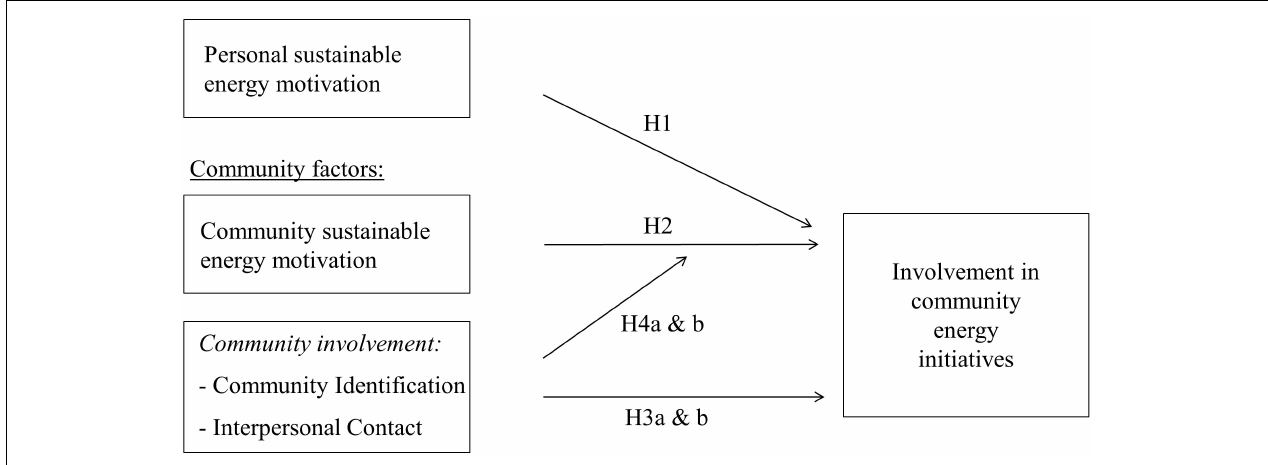
FIGURE 1 | Conceptual